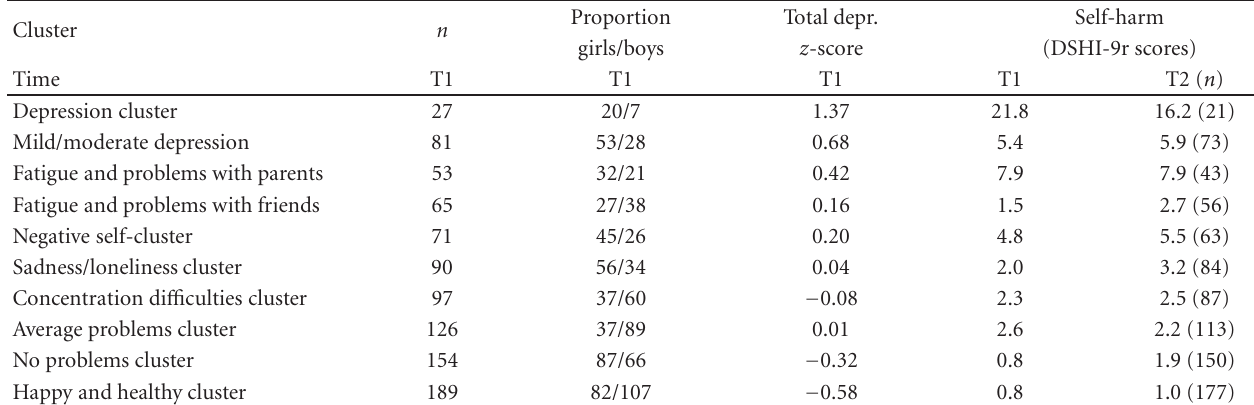
Table 3: Comparison between the clusters on gender, total depression score, and